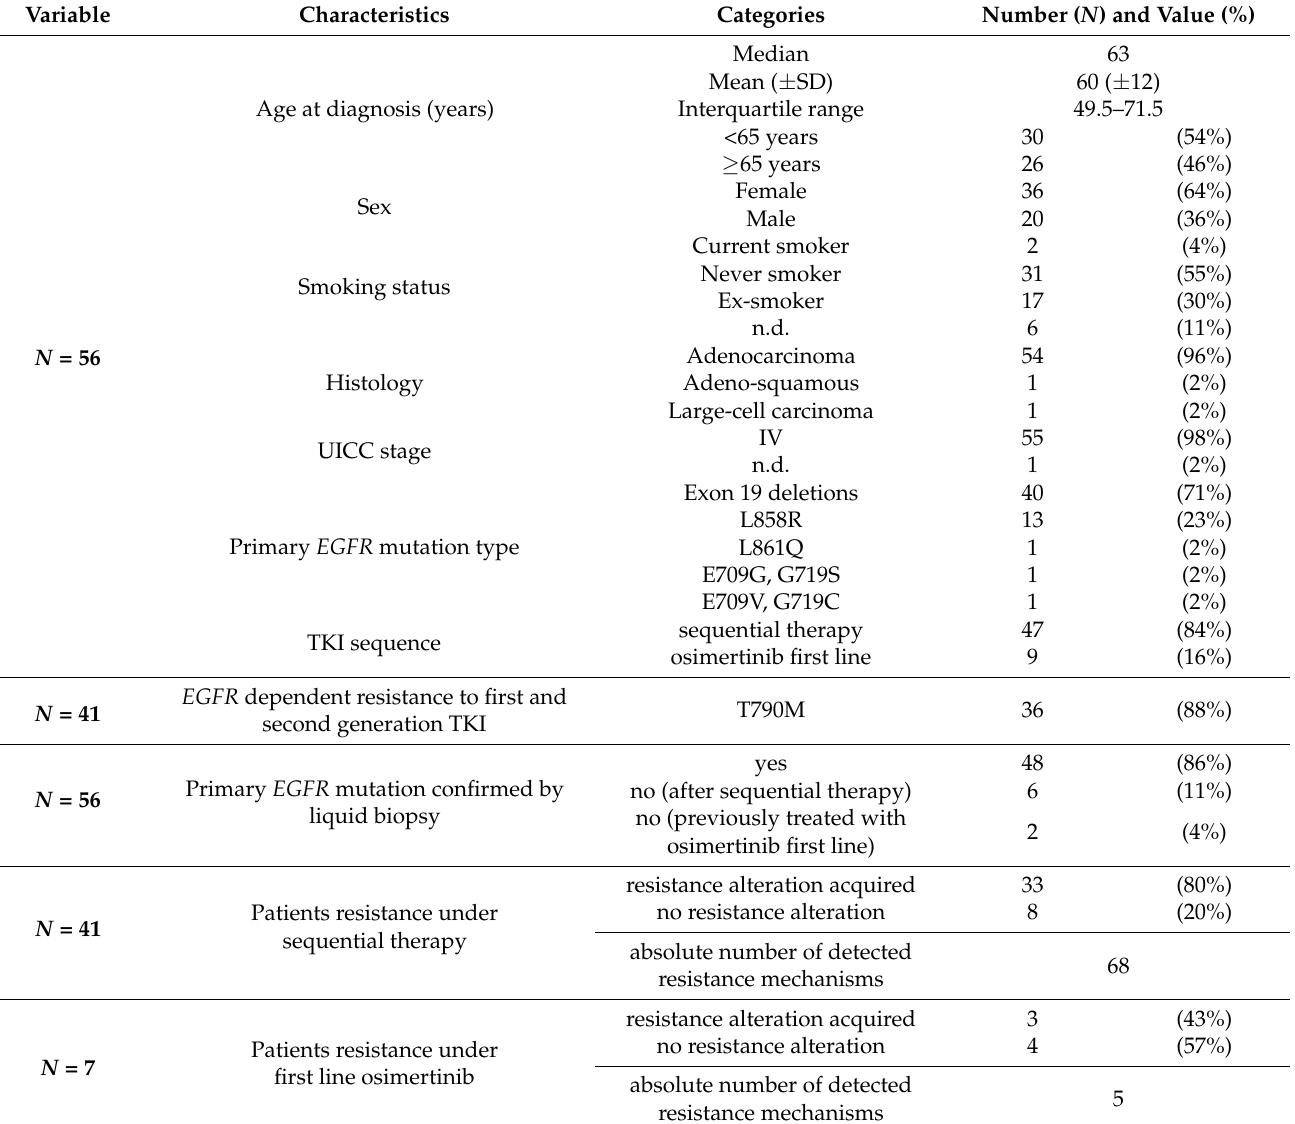
Table 1. Overview of patient